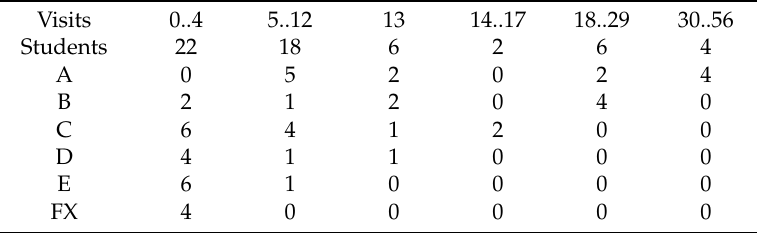
Table 1. The number of students based on lecture visits and final grade.